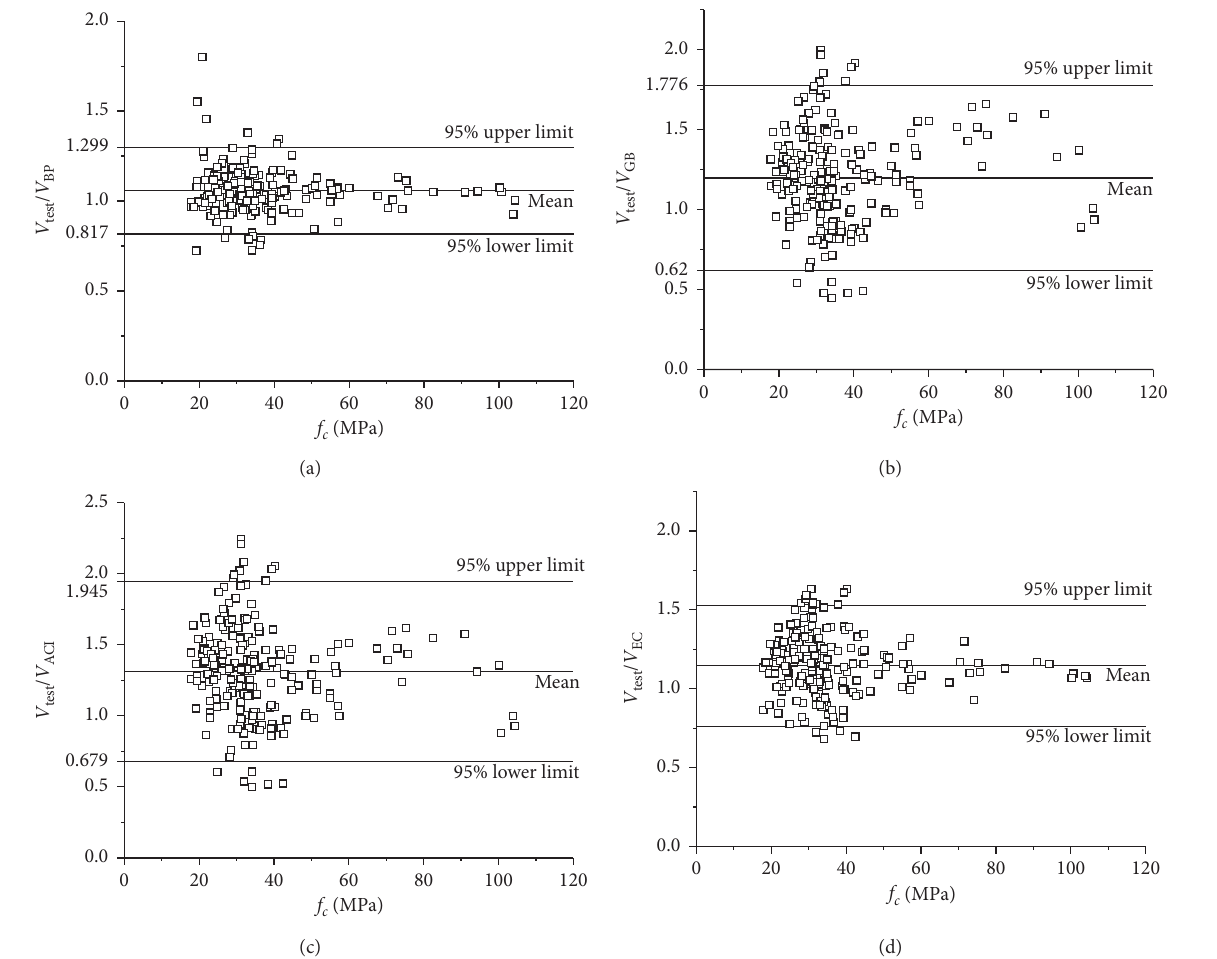
Figure 8: Influence of f on the ratio of the test value to the predicted value. (a) BPNN model. (b) GB 50010-2010. (c) ACI 318-14. (d) EC c